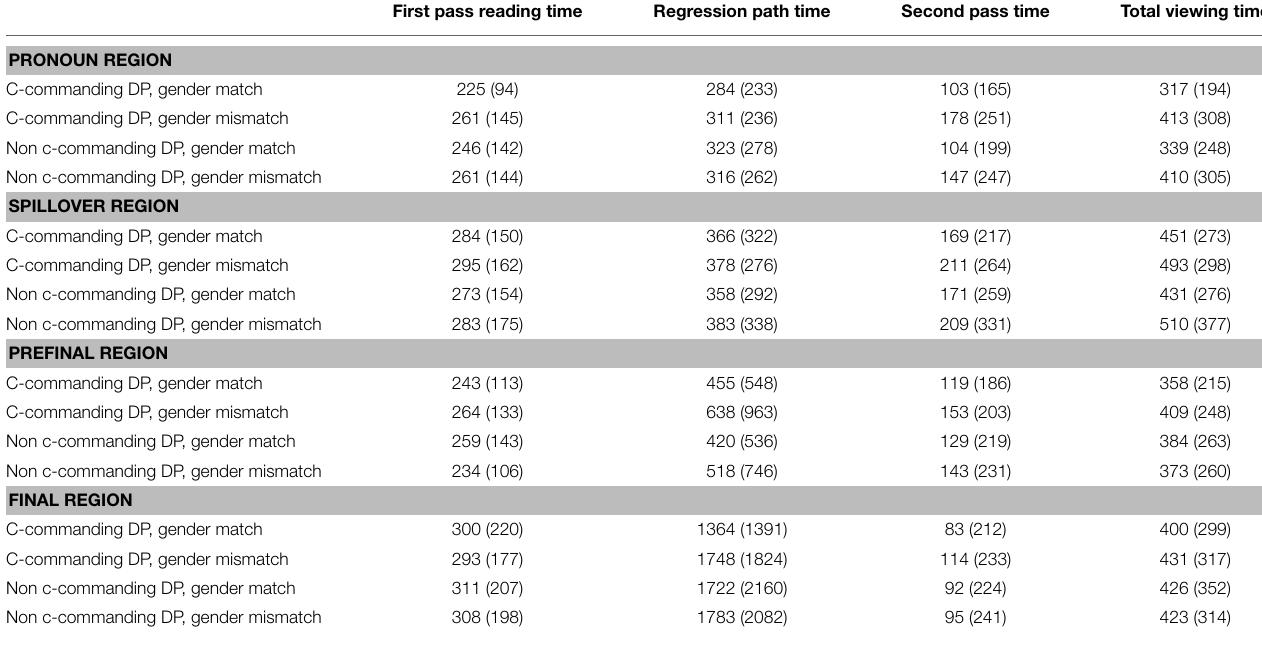
TABLE 4 | Summary of statistical analyses for four eye-movement measures at four regions of texts in Experiment 3. First pass reading time Regression path time Second pass time Total viewing time Estimate t Estimate t Estimate